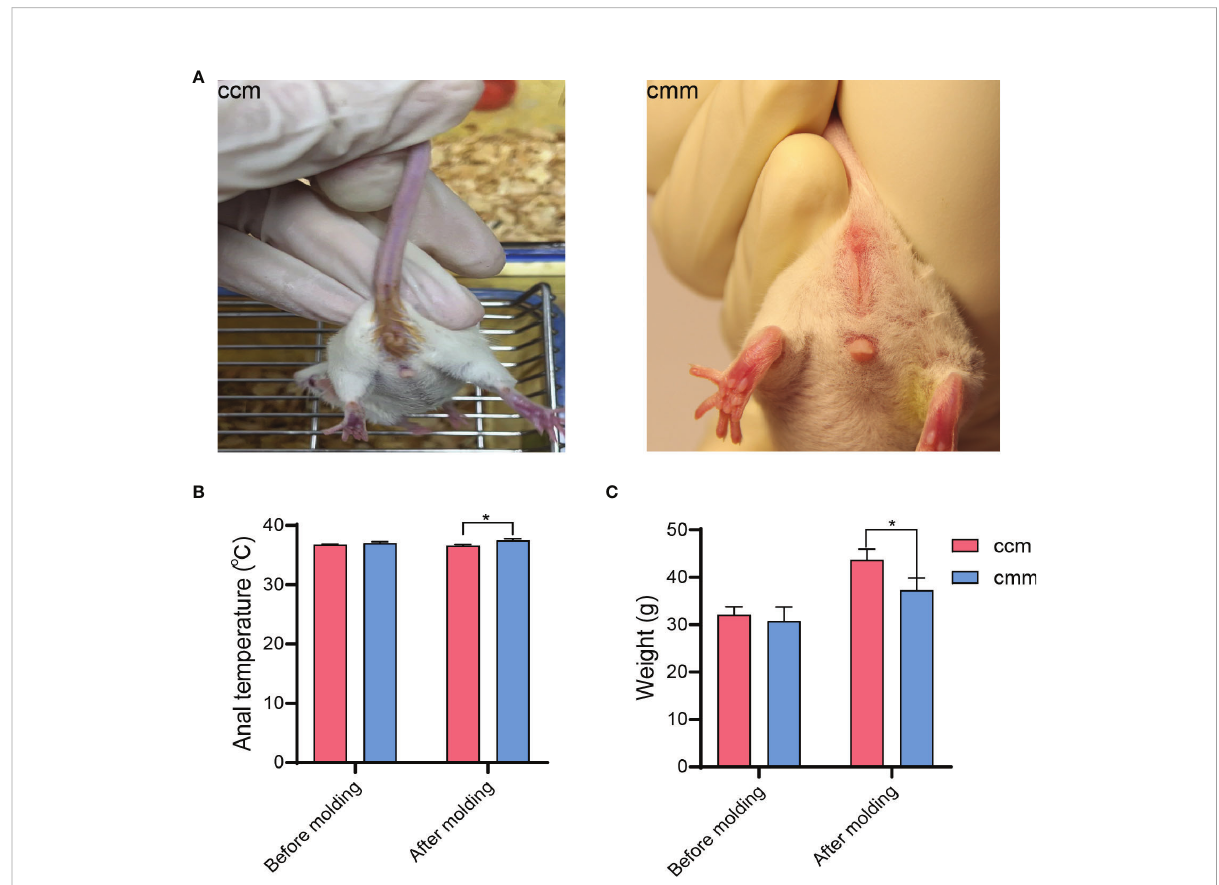
FIGURE 2 Behavioral changes in the mice. (A) Perianal of the mice. (B) The anal temperature of the mice. (C) Body weight (g) of the mice. ccm group, control group; cmm group, model group ( n = 5). The values were expressed as mean ± standard deviation. * p <